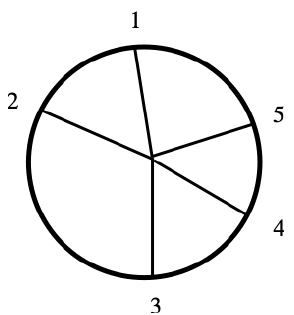
Figure 4. A contact Witten diagram. The information of derivatives in the quintic vertex is also suppressed in the